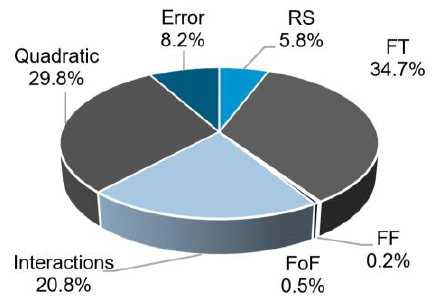
Figure 17. Contributions of the model factors to the response Dp.